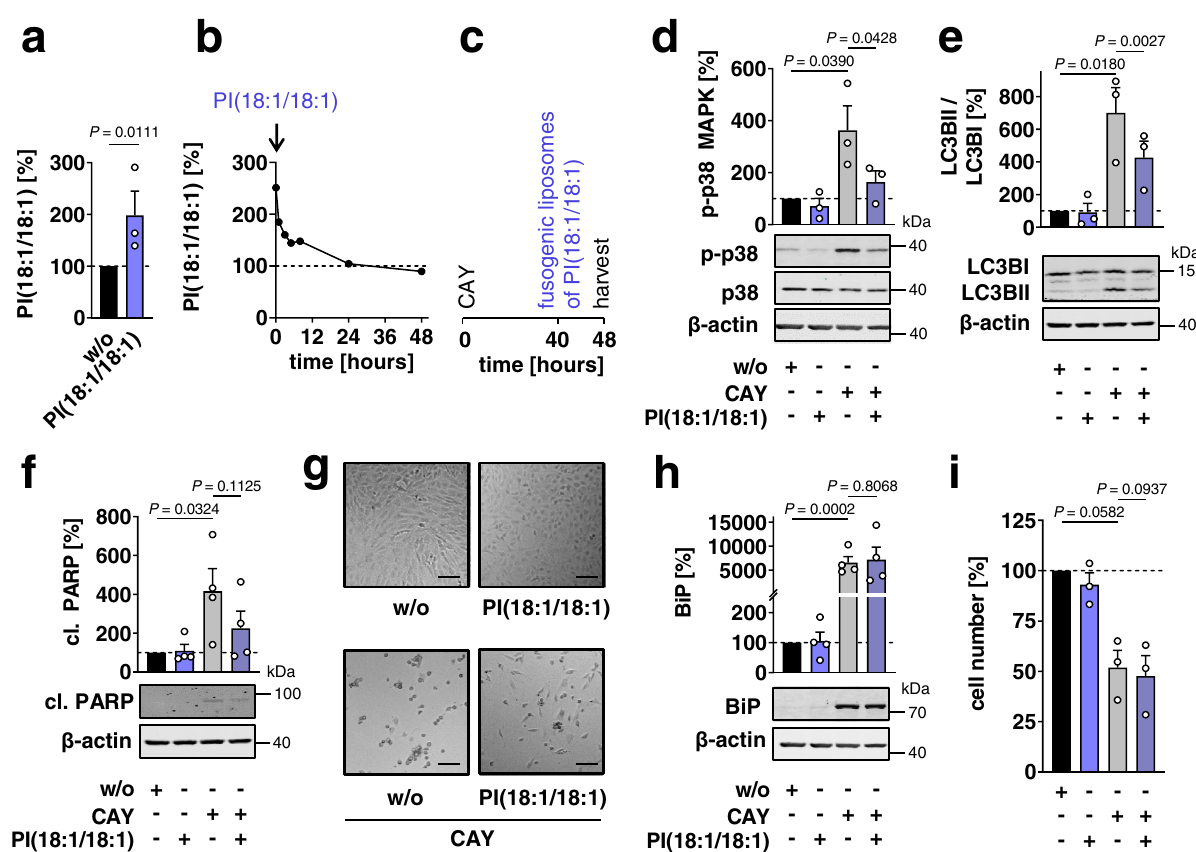
Fig. 7 PI(18:1/18:1) pulses shape the cellular stress response. a Cellular content of PI(18:1/18:1) directly after addition of the fusogenic phospholipid mixture with 3 nmol PI(18:1/18:1) to fi broblasts. b Time-dependent decrease of excess PI(18:1/18:1). c – i Fibroblasts were treated with vehicle or CAY10566 (CAY, 3 µ M) for 48 h, and PI(18:1/18:1) (3 nmol) was incorporated into cells using fusogenic liposomes 8 h before harvesting. c Time-scale. d Phosphorylation of p38 MAPK. e Ratio of LC3BII/LC3BI protein levels. f PARP cleavage; cl., cleaved. g Fibroblast morphology; scale bar, 100 µ m. Phase contrast images are representative of three independent experiments. h Protein expression of BiP. i Cell numbers. Western blots are representative of three ( d , e ) or four ( f , h ) independent experiments. Blots shown in panel d and f and e and h derive from the same membrane, respectively. Mean + s.e.m. and single data from n = 1 ( b ), n = 3 ( a , d , e , i ), n = 4 ( f , h ) independent experiments. Two-tailed paired student t test ( a , i ) of log data ( d – f , h